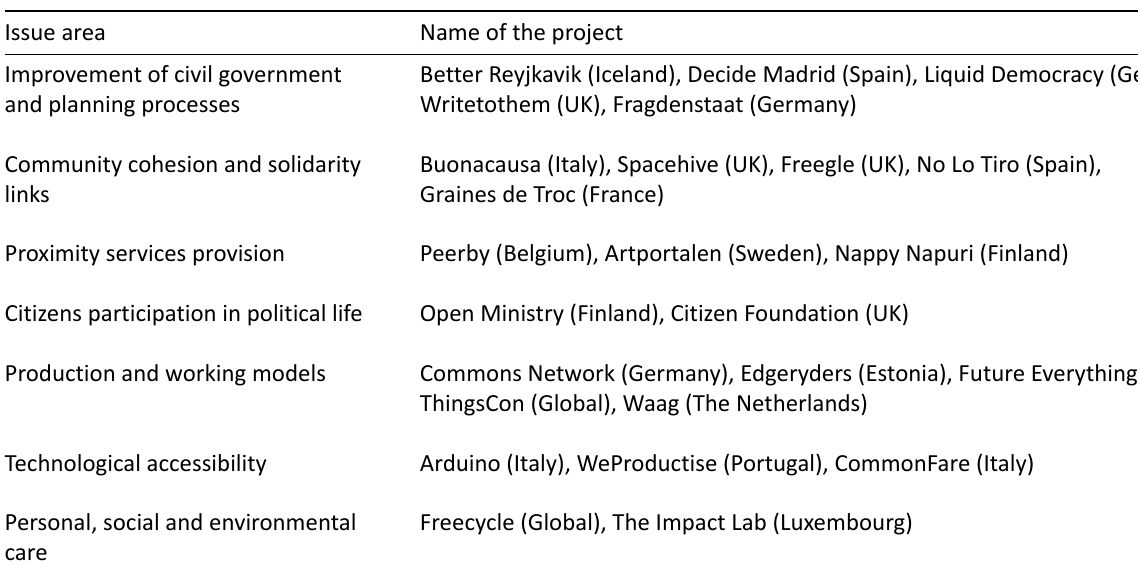
Table 1. Examples of non-EU-funded DSI